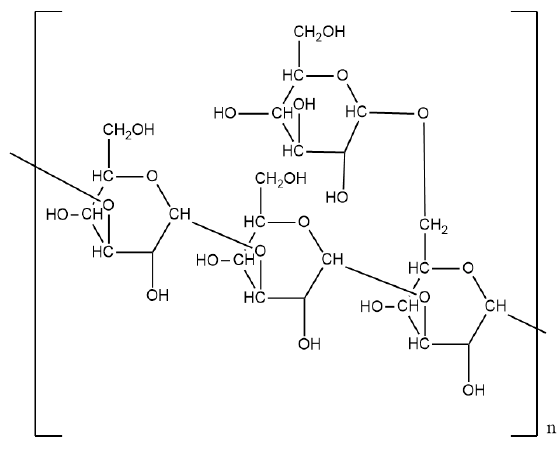
Figure 4. The molecular structure of Scleroglucan.